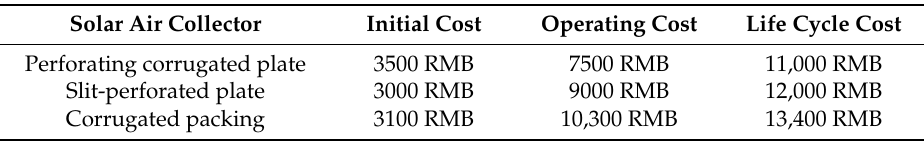
Table 2. Economic analysis of the three solar air